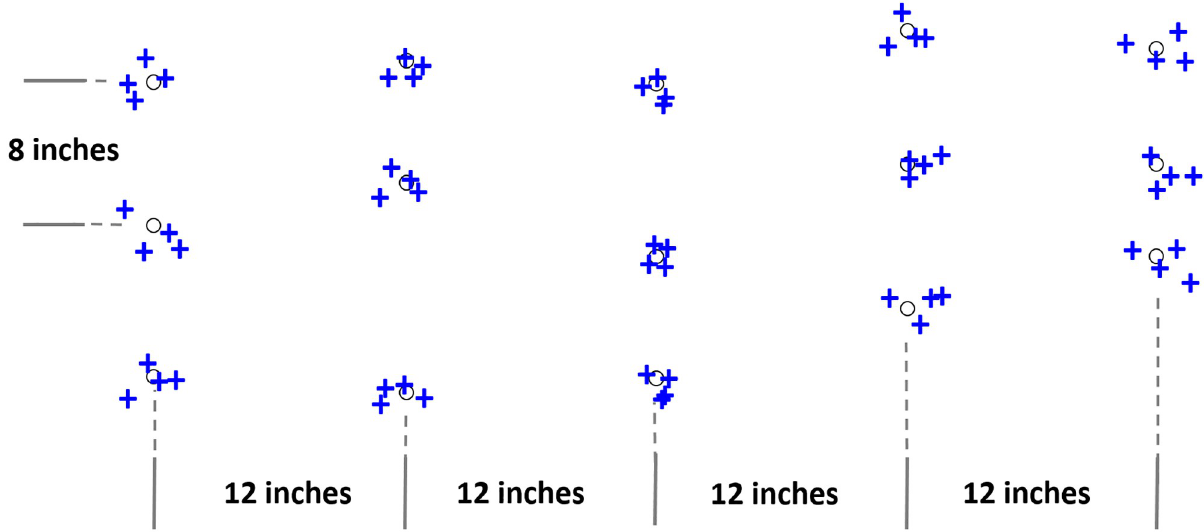
Fig 7. Approximate actual sprayed positions (plus sign) of the desired position (circle sign).